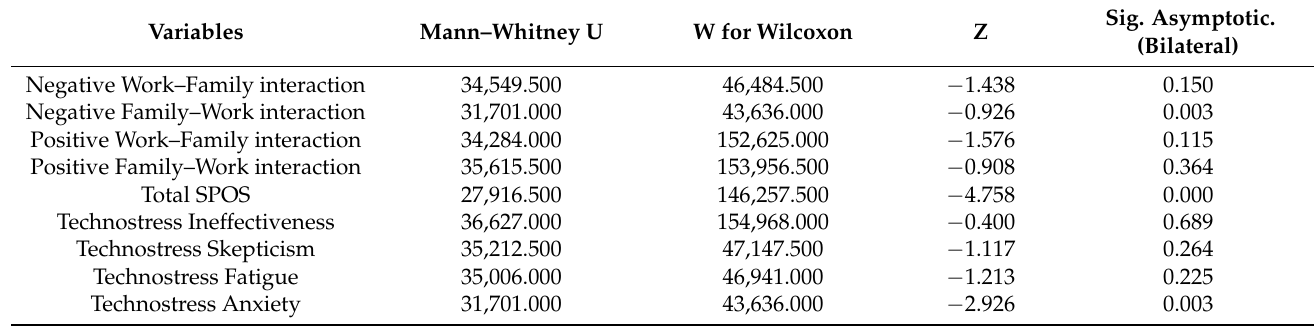
Table 1. Contrast statistics: Group differences in variables according to type of center.